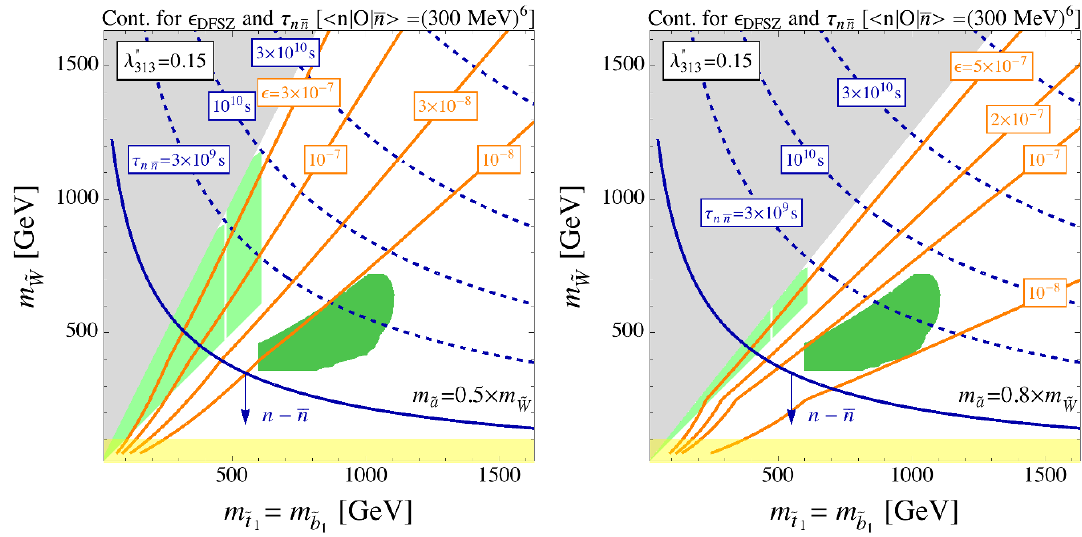
Figure 6 . Contours for (cid:28) nn and (cid:15) in the DFSZ scenario in the m parameters were taken as in (cid:12)gure 5 unless otherwise indicated. The light-green area is excluded by the ATLAS four-jets search [35], the dark-green region by the multijets search [36]. The yellow region is excluded by LEP, while in the gray-shaded area the axino is not the